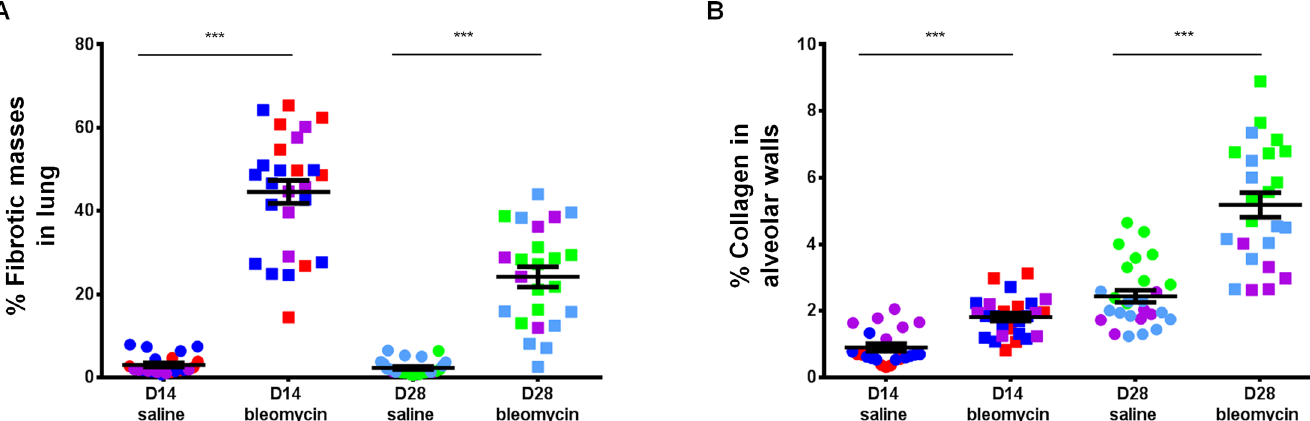
PLOS ONE | https://doi.org/10.1371/journal.pone.0193057 March 16,